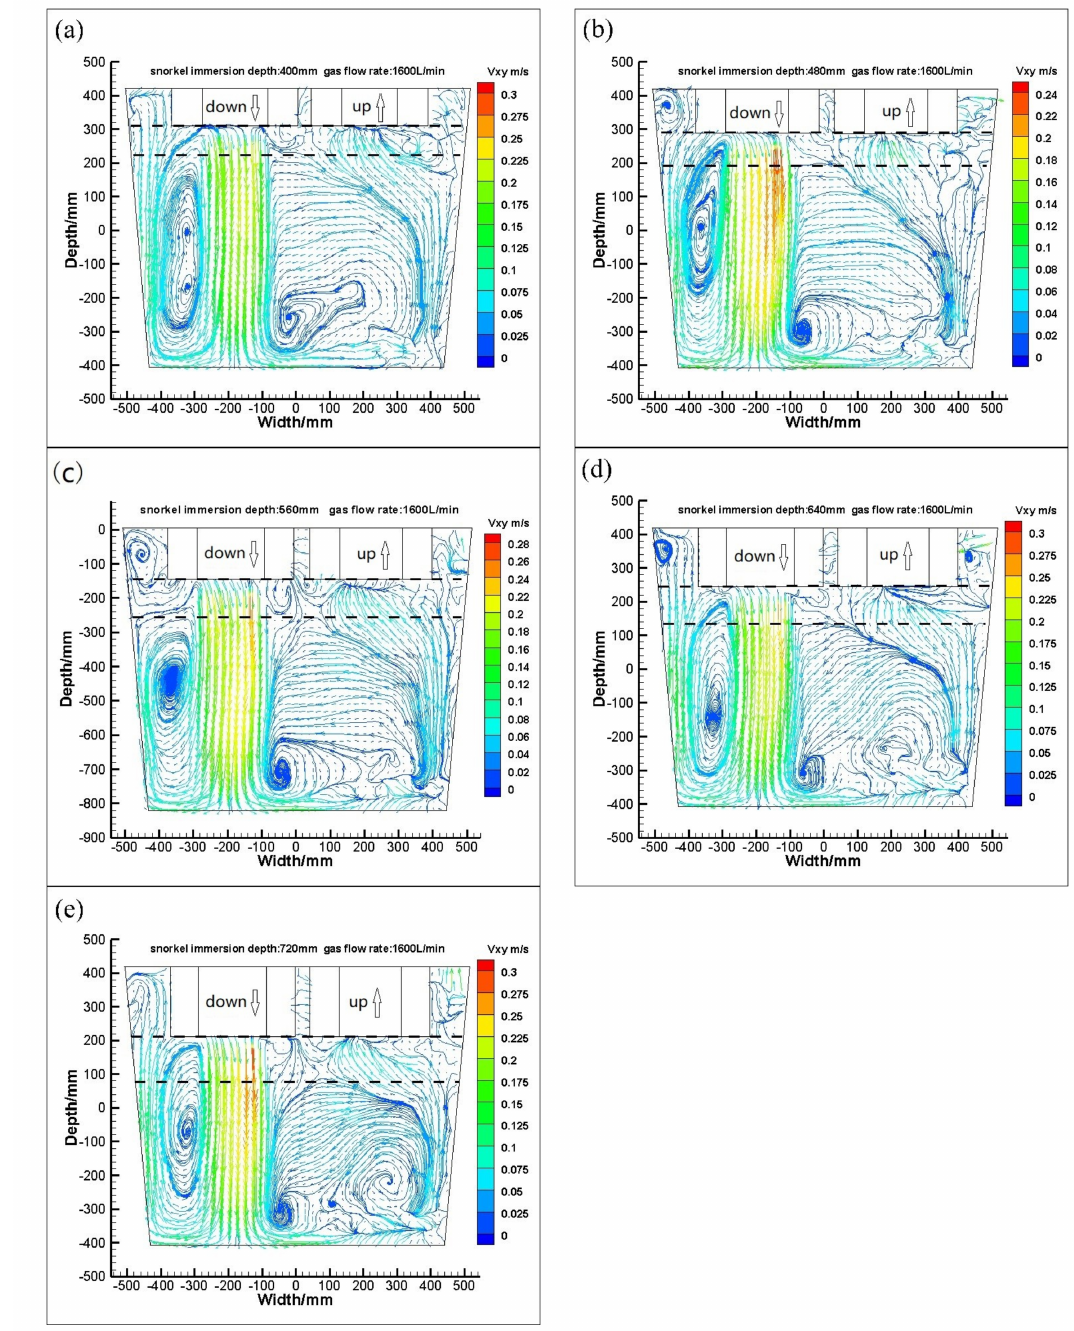
Figure 8. RH ladle flow field with di ff erent SIDs: ( a ) 400 mm; ( b ) 480 mm; ( c ) 560 mm; ( d ) 640 mm; ( e ) 720